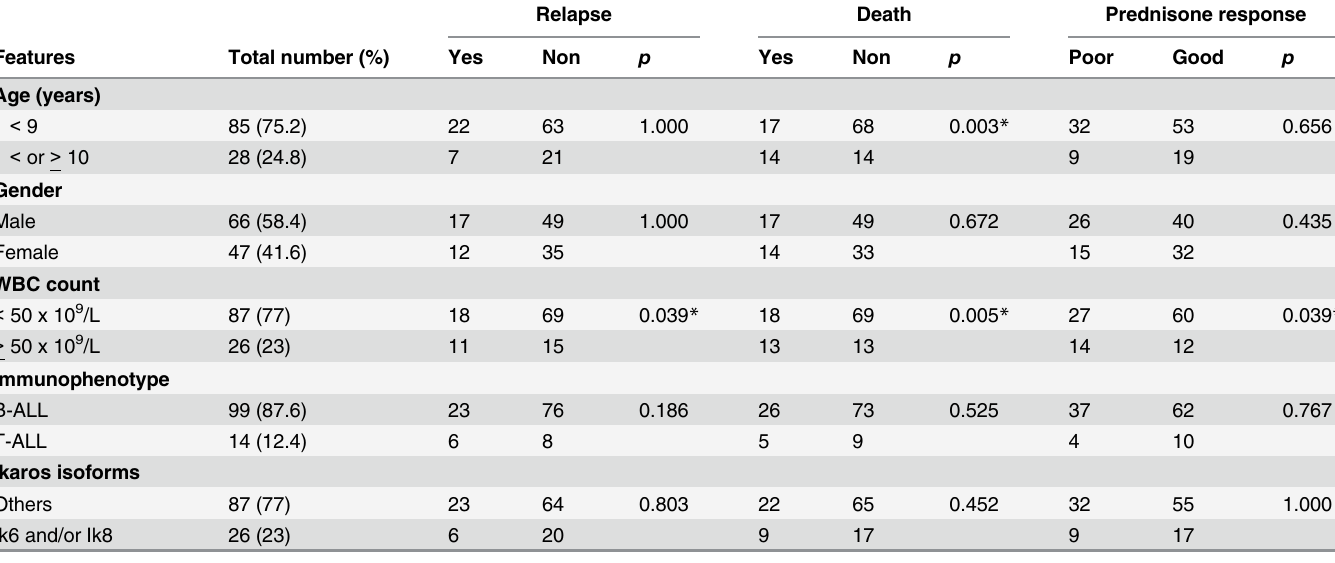
Table 2. Clinical-biological characteristics and Ikaros isoforms expression in ALL children and their association with relapse, death or prednisone response. Relapse Death Prednisone